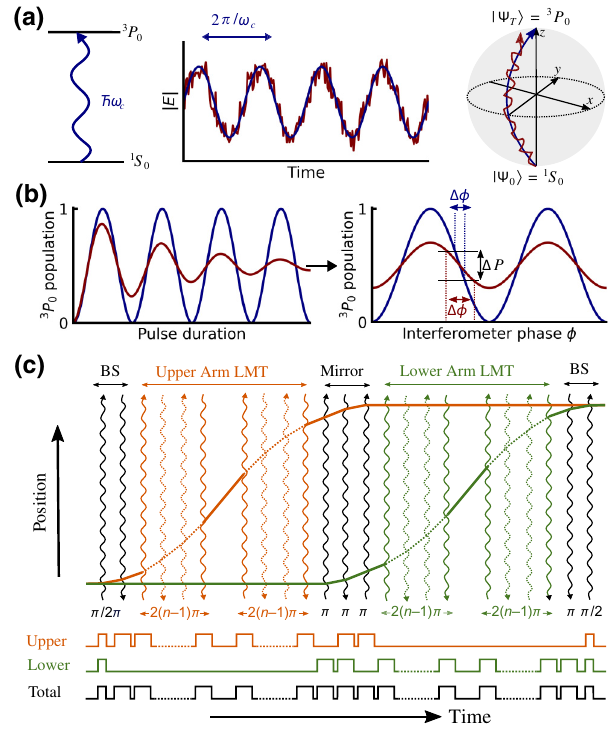
FIG. 1. (a) Clock atom interferometers operate on the metastable 1 S 0 – 3 P 0 transition, which is ideally driven by a noise- less laser (blue line). A noisy laser system (red line) will instead introduce errors when applying operations, such as for a π pulse as shown here in the Bloch-sphere representation of the two-level system. (b) These imperfections lead to damping in the temporal domain and also to a loss of interferometry visibility and hence interferometric sensitivity. (c) The proposed LMT scheme for a large-area clock atom interferometer [8]. The black lines repre- sent the basic interferometry scheme, while the orange and green lines represent the LMT pulses applied to the upper and lower arms, respectively. The upper and lower arms of the interferom- eter receive different pulses but with a pattern that is symmetric in